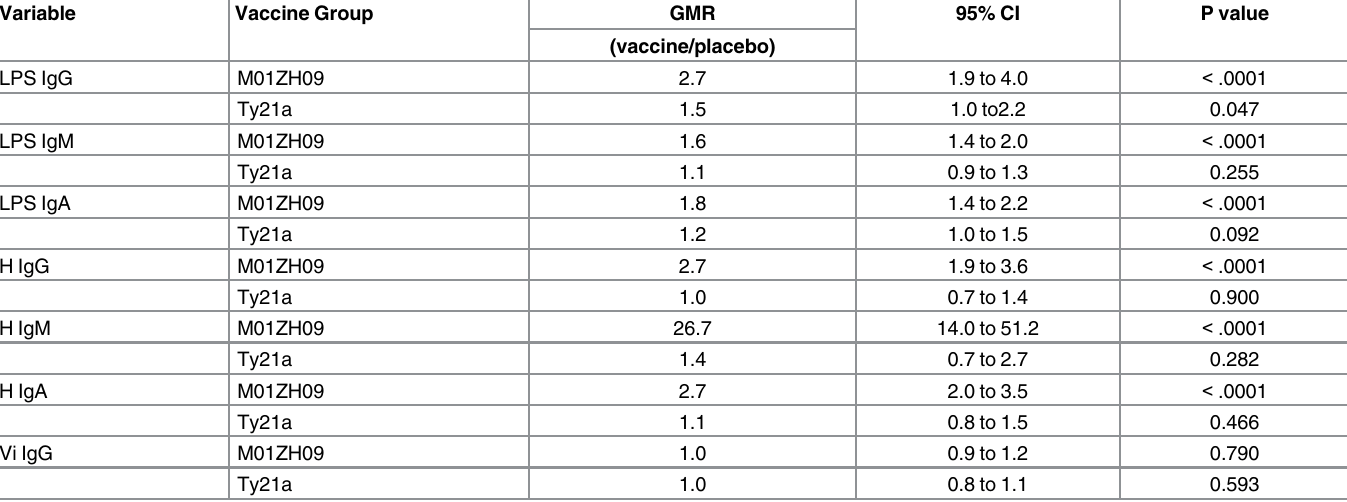
Table 6. Analysis of covariance comparisons for increase in antibody titres against LPS, flagellin (H) and Vi between pre-vaccination (Day -28) and Day 0 (prior to challenge), between each active vaccine group (1. M01ZH09 and 2. Ty21a) and placebo. Analysis were performed with the dependent variable log(change from baseline) with adjustment for log(pre-vaccination) values. GMR, geometric mean ratio compared to placebo.